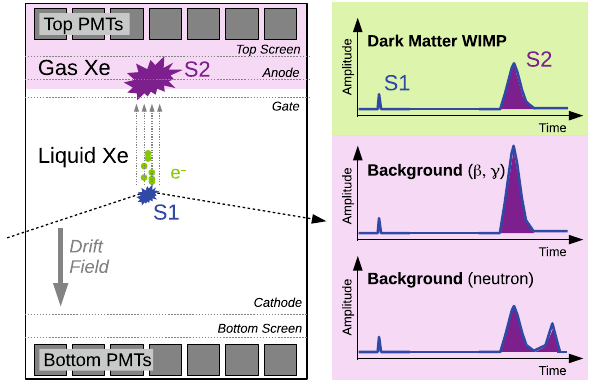
Fig. 1 Working principle of a dual-phase LXe TPC: The prompt scin- tillation light (S1) generated in the LXe is recorded by PMTs installed above and below the target. The same PMTs also measure the delayed secondary-light signal S2, which is created by proportional scintilla- tion induced by ionization electrons (e − ) in the gas phase. A set of TPC electrodes is used to establish the required electric fields. The inter- action position can be reconstructed in 3-dimensions by means of the S2-signal pattern observed by the top PMTs (lateral) and the time dif- ference between S1 and S2 (depth). Background events are rejected by the charge to light (S2/S1) ratio and the scatter multiplicity (number of S2 signals), as indicated on the panels on the right